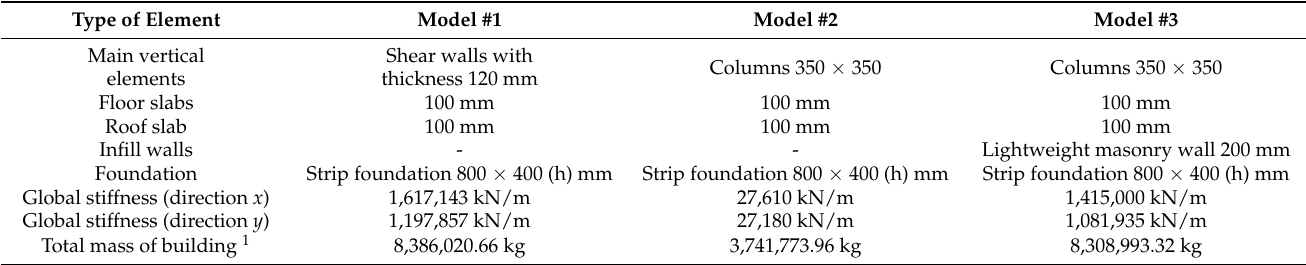
Table 2. Structural geometry description of the numerical reference models.